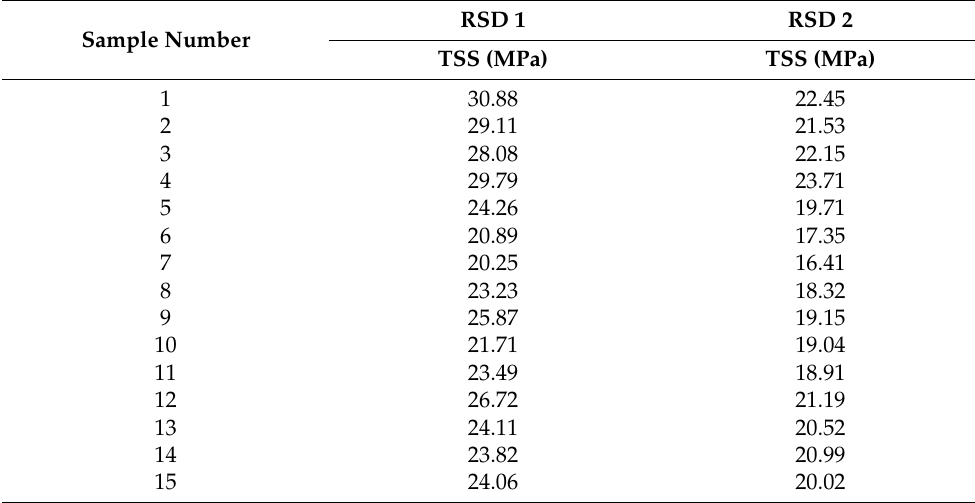
Table 8. Average response in terms of TSS of laser-treated joints for both